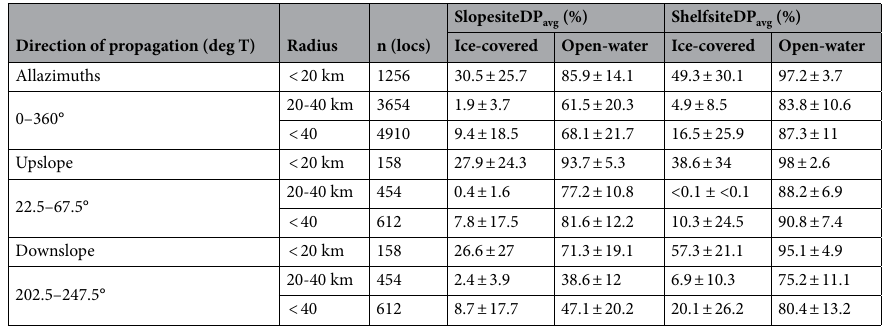
Table 2. Average simulated detection probability (DP) with 70 dB re 1 μPa 2 noise spectrum level in the 80–180 Hz band for sounds traveling in all directions (All azimuths), toward shallower water (Upslope), and toward deeper water (Downslope) at the slope and shelf recording sites. Values are average and standard deviation of all 1 km 2 model locations within radii < 20 km, 20–40 km, and for all locations < 40 km. Number of locations included in statistical computation given as n(locs).